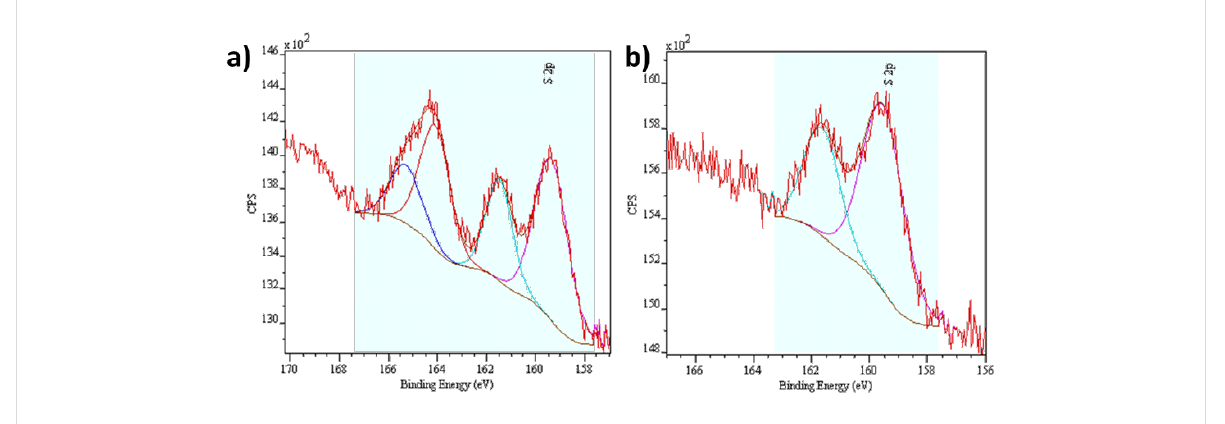
Figure 7: XPS spectra of a film immersed in MHA solution a) before and b) after rinsing with EtOH.